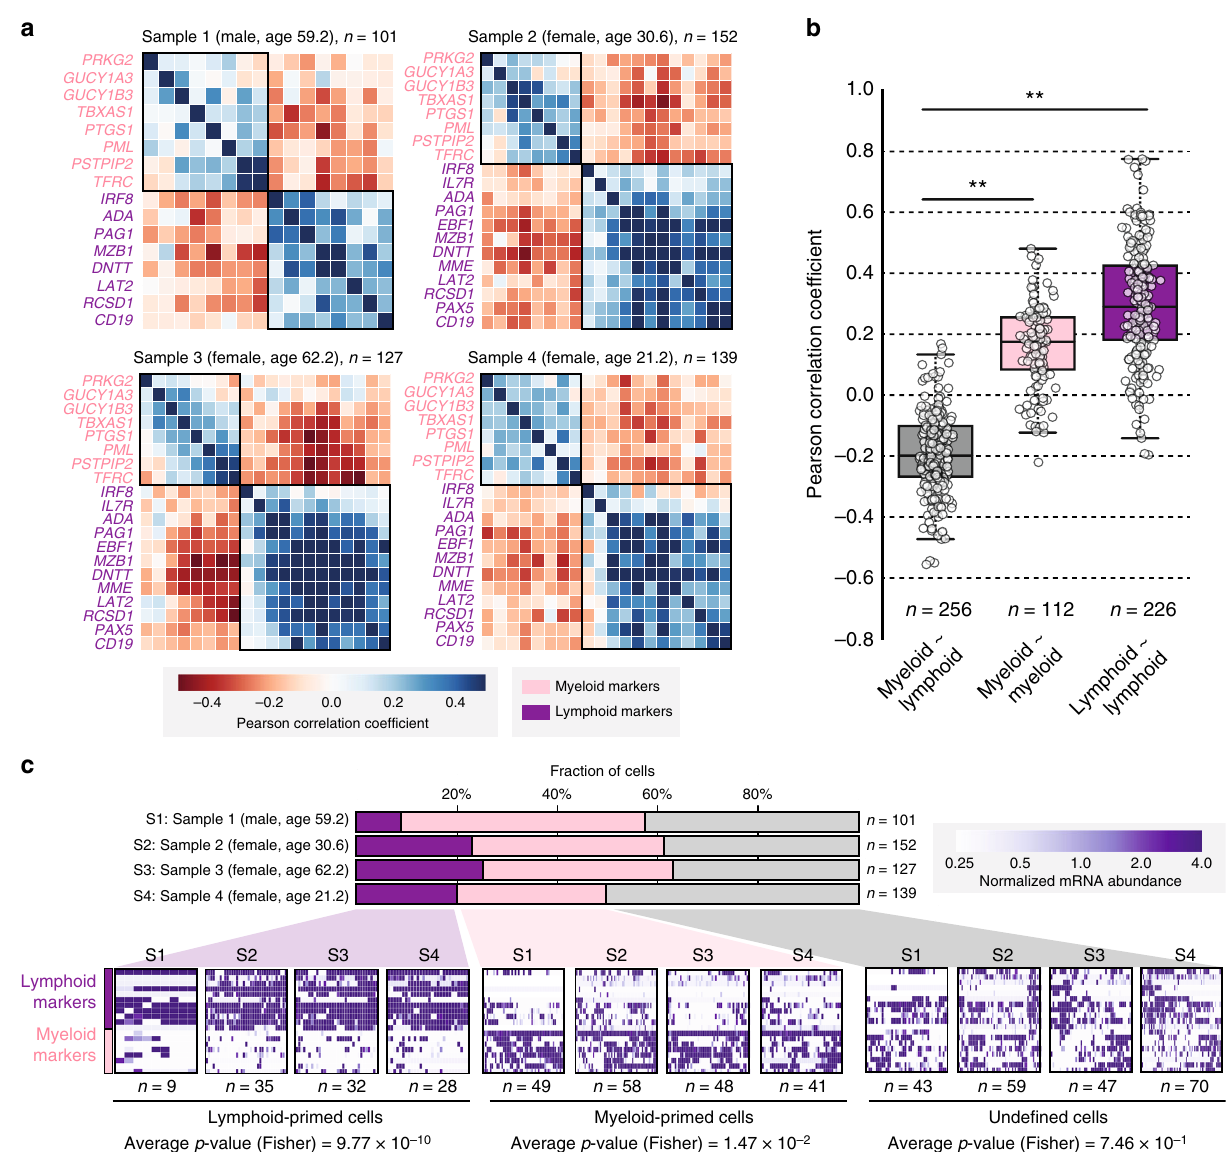
Fig. 6 Classi fi cation of single CD34 + cells into myeloid- and lymphoid-primed cells. a The matrices show the correlation (Pearson) of the abundance of the mRNA markers speci fi c for lymphoid or myeloid differentiation (see also Fig. 5c) in single HPCs. b The distribution of correlation values (Pearson) between myeloid and lymphoid markers (grey), between myeloid markers only (pink), and between lymphoid markers only (purple) is presented as box plot. The central line in the box plots indicates the median, the bottom and top edges of the box the IQR, and the box plot whiskers represent 1.5 times the IQR. Correlation values are taken from all four samples. Signi fi cance was assessed using Mann – Whitney U -test (** p value < 0.01). c Cells are classi fi ed into lymphoid- and myeloid-primed cells based on markers. The bar-plot gives an overview on the fraction size of lymphoid-primed (purple), myeloid-primed (pink), and unde fi ned (grey) cells in a given sample (unde fi ned meaning that cells could not be classi fi ed as myeloid or lymphoid). For each fraction and each sample (S1 – S4) the heat maps show the mRNA abundance of lymphoid and myeloid markers. The signi fi cance of marker distributions in each